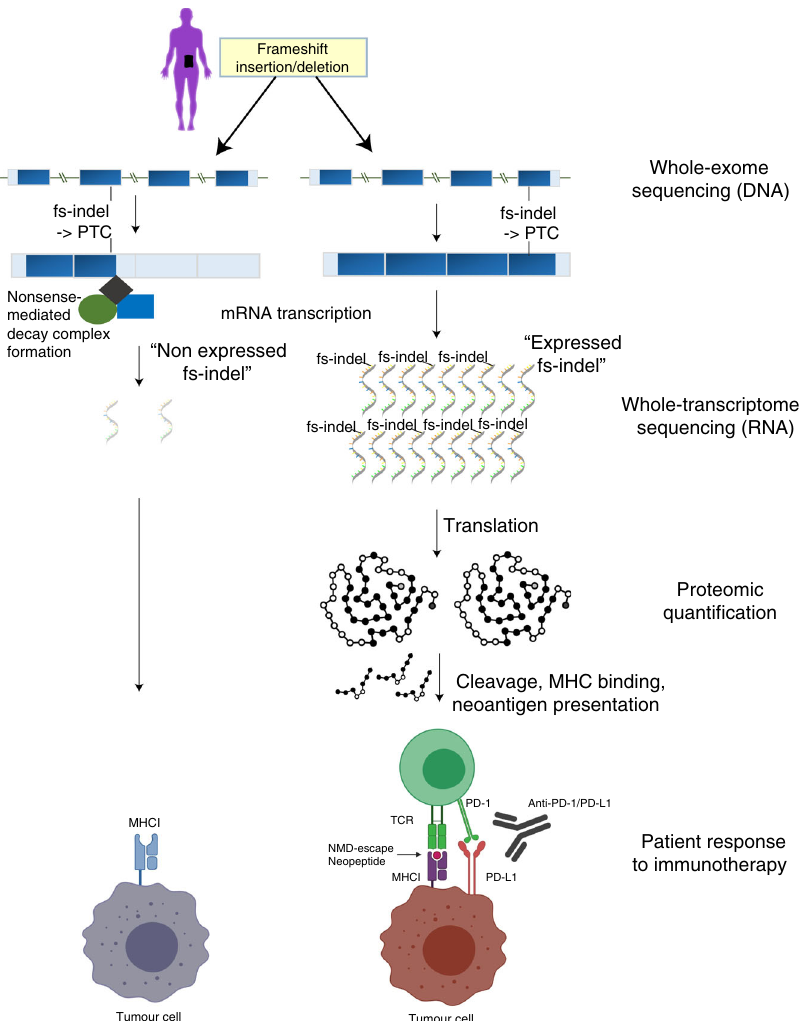
Fig. 1 Allele-speci fi c expression analysis using matched DNA and RNA sequencing data. Shows an overview of study design and methodological approach. The left-hand side of the panel shows a fs-indel triggered premature termination codon, which falls in a middle exon of the gene, a position associated with ef fi cient nonsense-mediated decay (NMD). The right-hand side of the panel shows a fs-indel triggered premature termination codon, which falls in the last exon of the gene, a position associated with bypassing